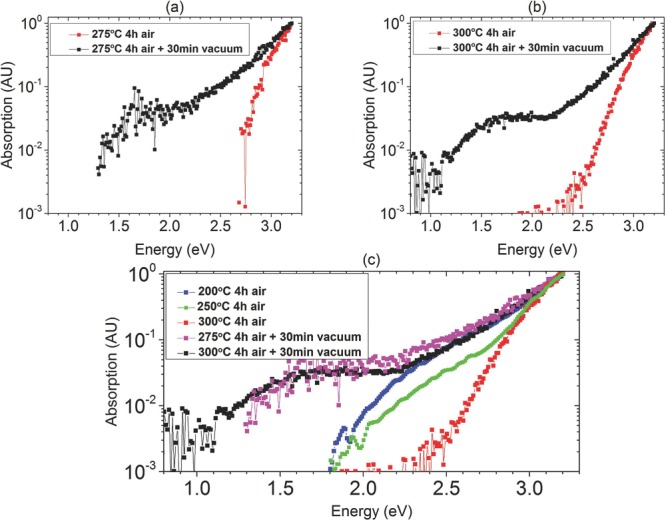
PDS spectra. The data are normalized with respect to the maximum absorption
close to the band gap energy ≈3.2 eV to eliminate any effects arising
from different thicknesses between samples. a,b) Samples annealed in air for
4 h (red) and samples with additional 30 min of vacuum annealing (black) at
275 °C a) and 300 °C b); c) Comparison between samples with 30
min additional vacuum annealing at 275 °C (pink) and 300 °C
(black) with only air annealed samples at 200 (blue), 250 (green), and 300
°C (red).